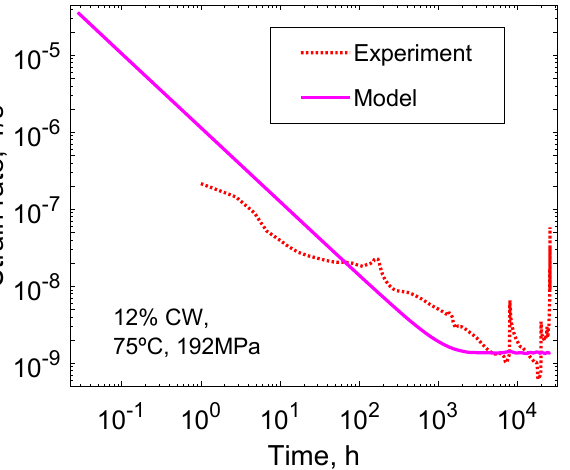
Figure 11. Creep rate versus time for 12% cold-work Cu-OFP at 75 °C and 192 MPa. Model results from Equation (11). Redrawn with permission from ref. [16]. Copyright 2022 Elsevier.